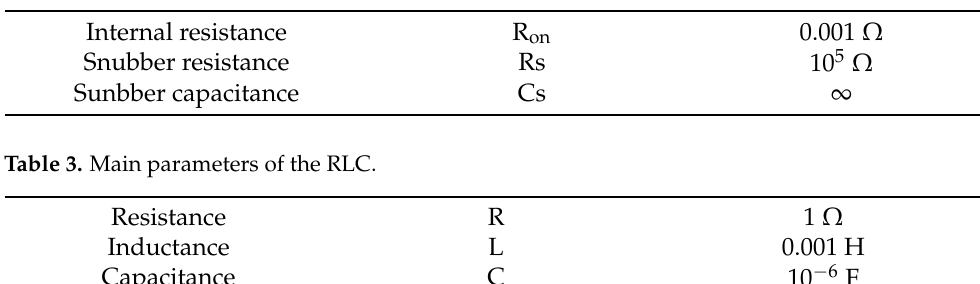
Table 1. Microgrid system parameters.